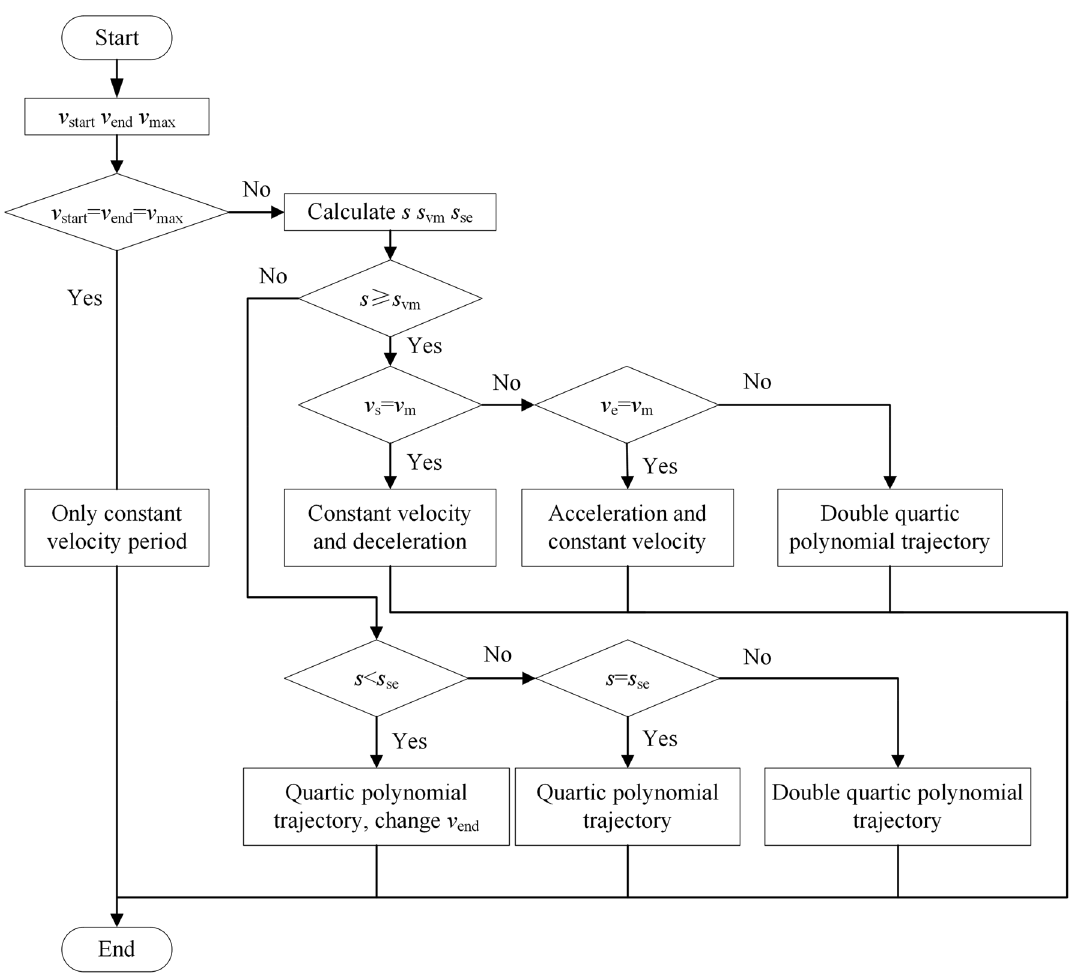
Figure 4 Flowchart of double-quartic polynomial trajectory planning